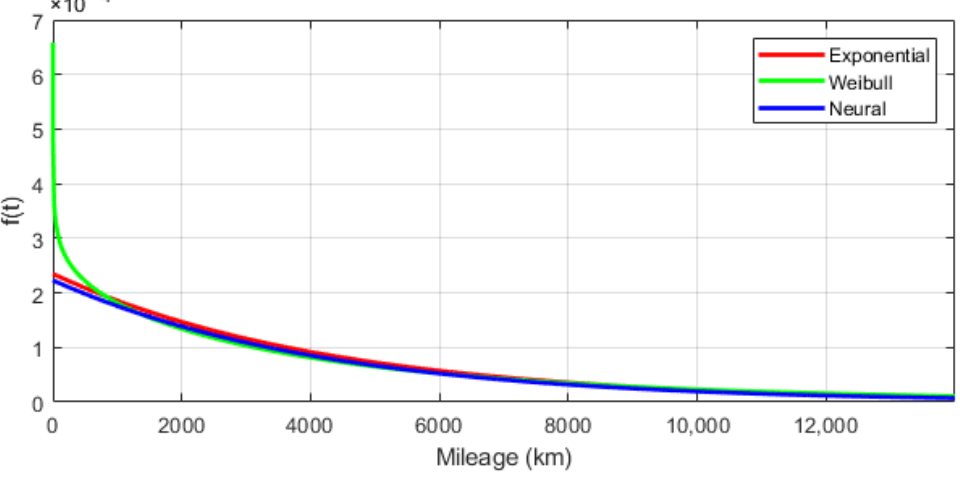
Figure 11. Probability density functions of reliability models.